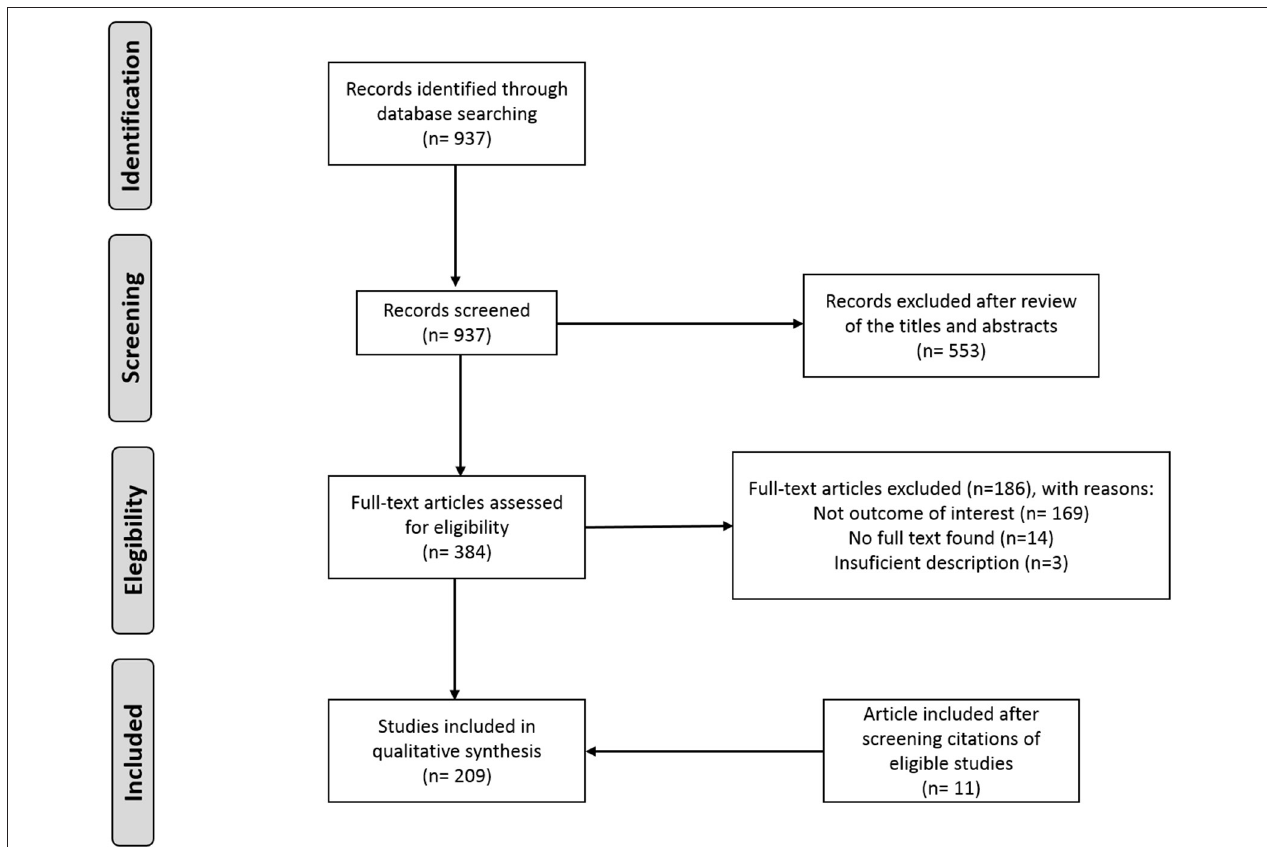
FIGURE 2 | Flow diagram of the results from the literature search and the study